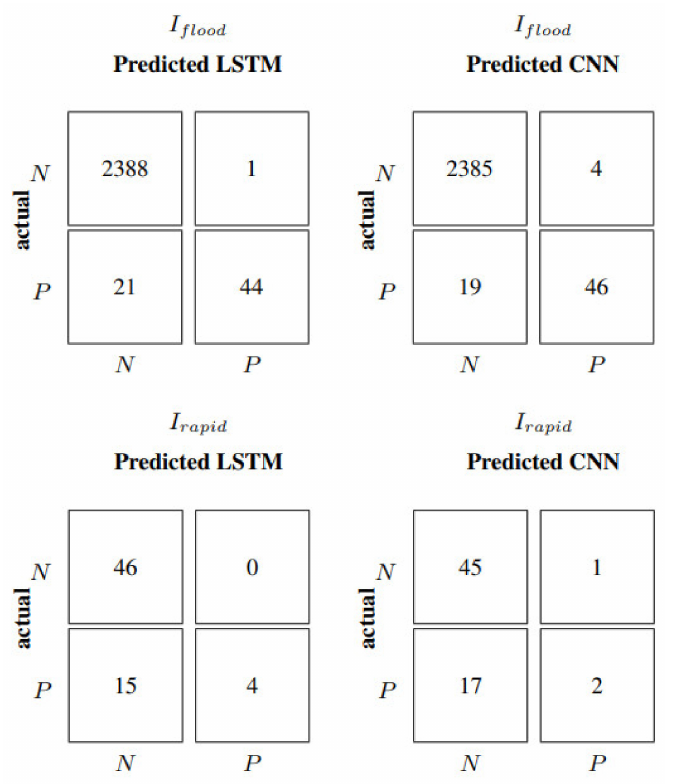
Figure 8. I flood and I rapid for multivariable LSTM and CNN models in the total rain scenario. Test data, Lura River. P means a flood or a rapid event is present, N means that it is not.